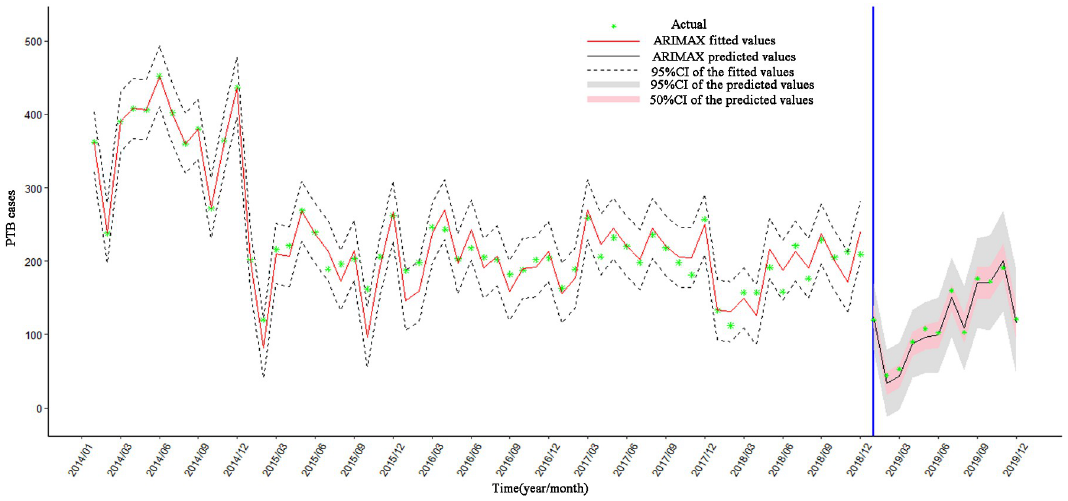
Fig 9. The fitting and predicting results of the ARIMAX(1,1,2) × (0,1,1) 12 +PM 2.5 (lag = 12)model.